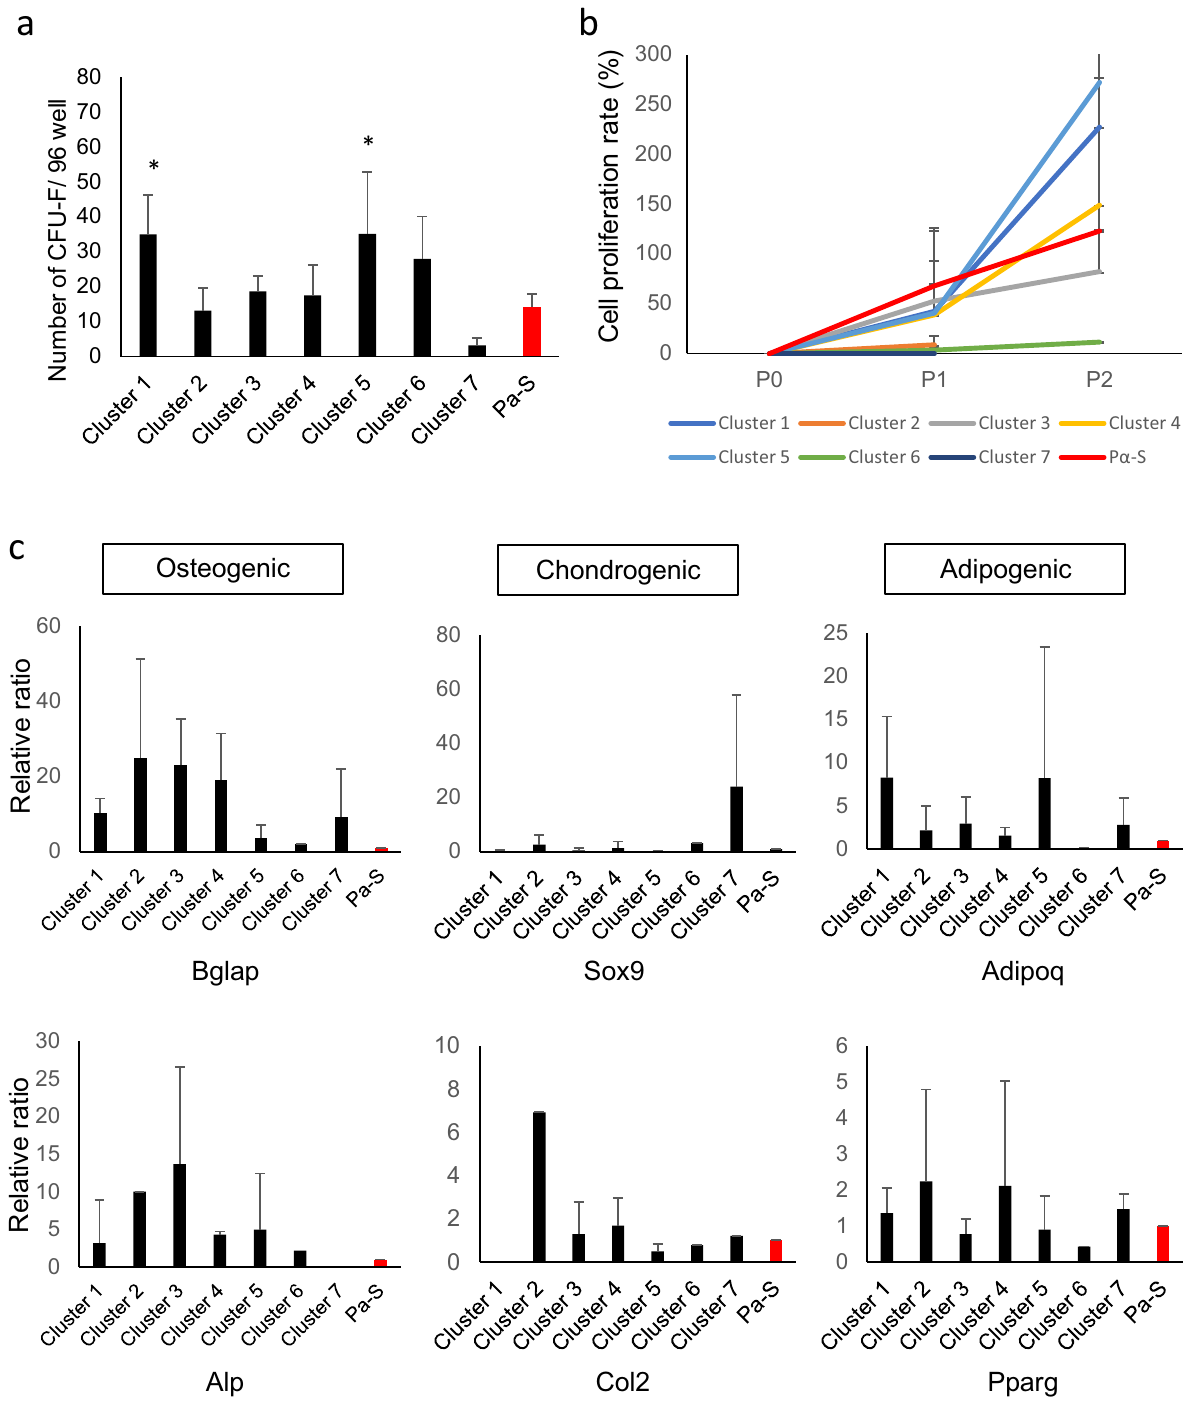
Figure 5. Stem cell properties of each cluster. ( a ) Graph showing bone marrow fibroblastic colony forming unit (CFU-F). * P < 0.01 versus Pα-S (n = 9). ( b ) Cell proliferation assay for each cluster. ( c ) Real Time PCR analysis for mesenchymal lineage marker expression in each cluster following 2-week treatment with mesenchymal differentiation media. ** P < 0.05 versus Pα-S (n =